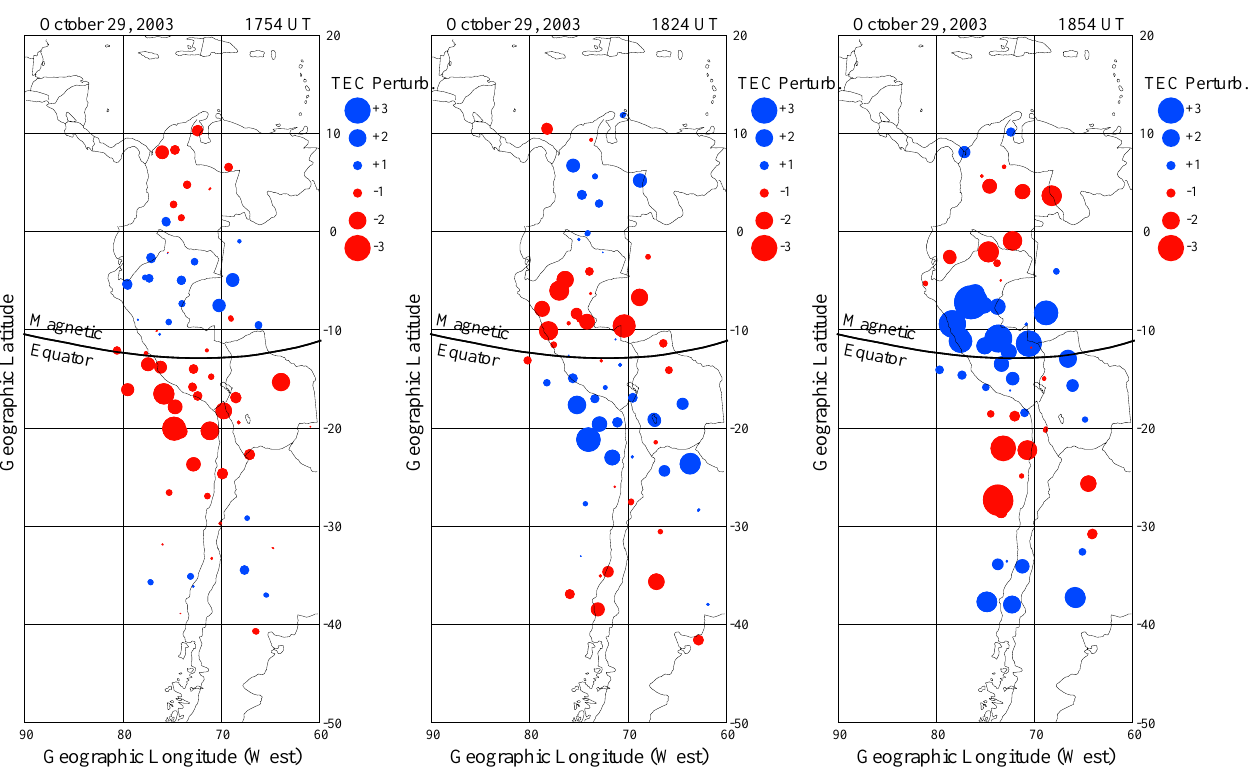
Fig. 3. Similar to Fig. 2 but for TEC perturbations observed in South America for 3 instances separated by 30min. Note the size of the small circles indicate the amplitude of the TEC perturbations that vary between − 3 and 3TECu.